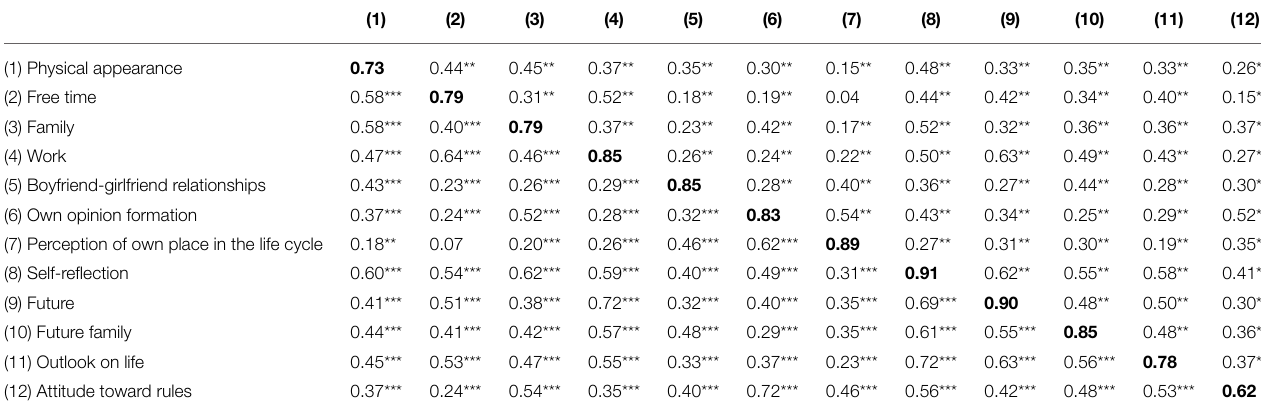
TABLE 2 | Correlations between the variables measured by the EIES (correlations between observed variables are above the diagonal, and correlations between latent variables are below the diagonal) and Cronbach’s alpha on the diagonal (in